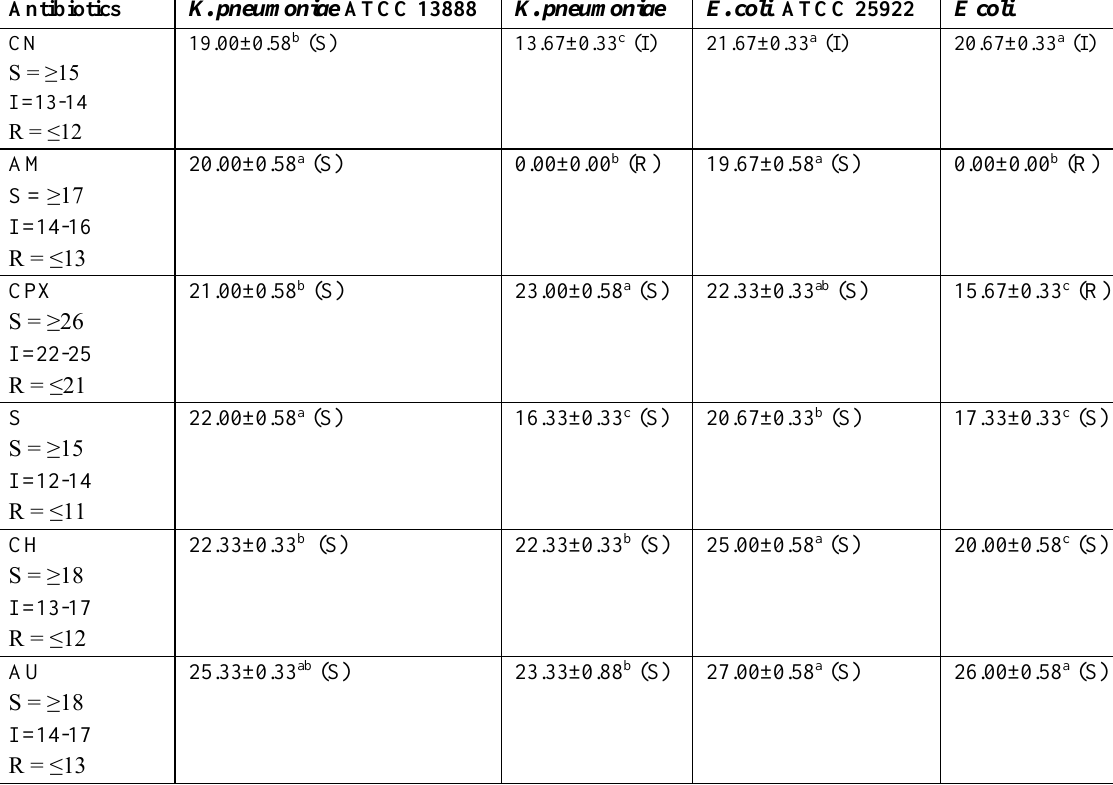
Table 2b. Comparative antibacterial activities of some conventional antibiotics on Gram negative clinical and typed isolates involved in throat